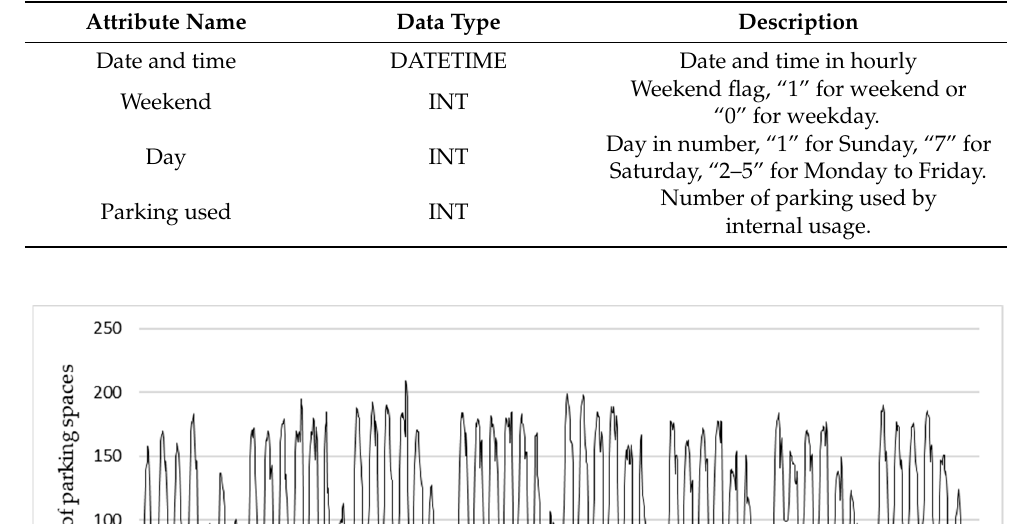
Table 3. Attributed description of data after data preprocessing.